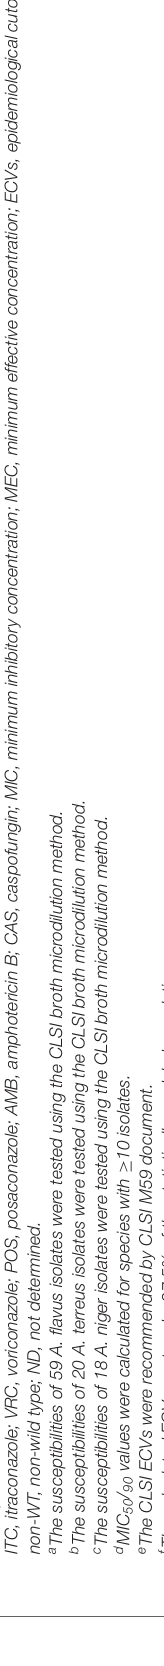
TABLE 3 | The single and multidrug resistance of 706 Aspergillus spp. isolates to antifungals. Aspergillus species (number of isolates tested)